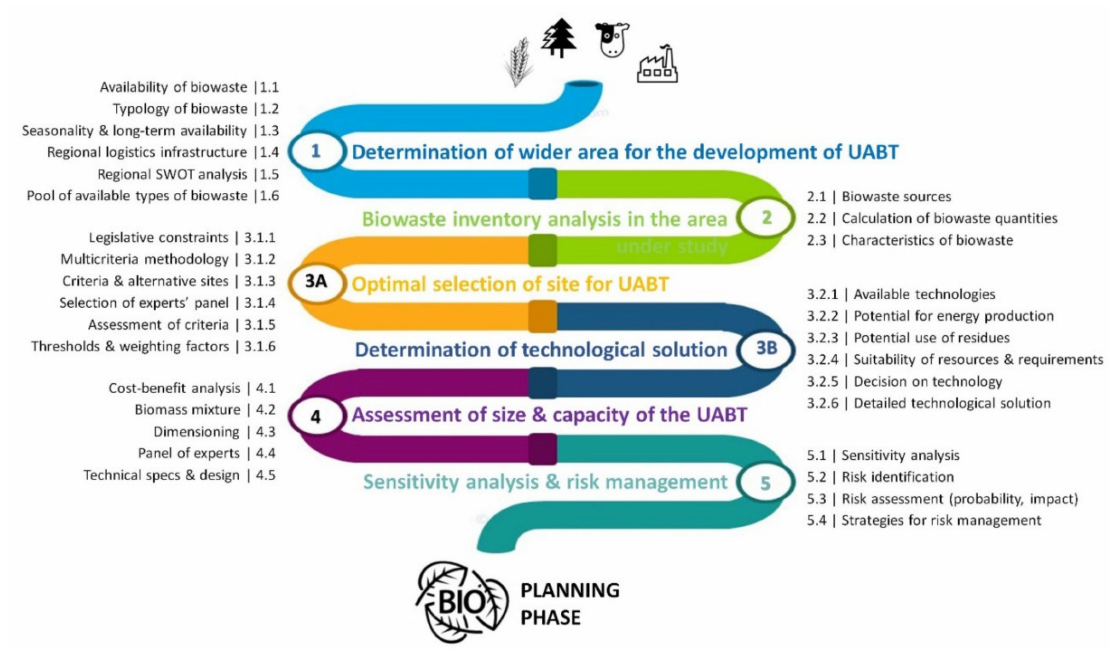
Figure 1. Basic structure and components of the methodological